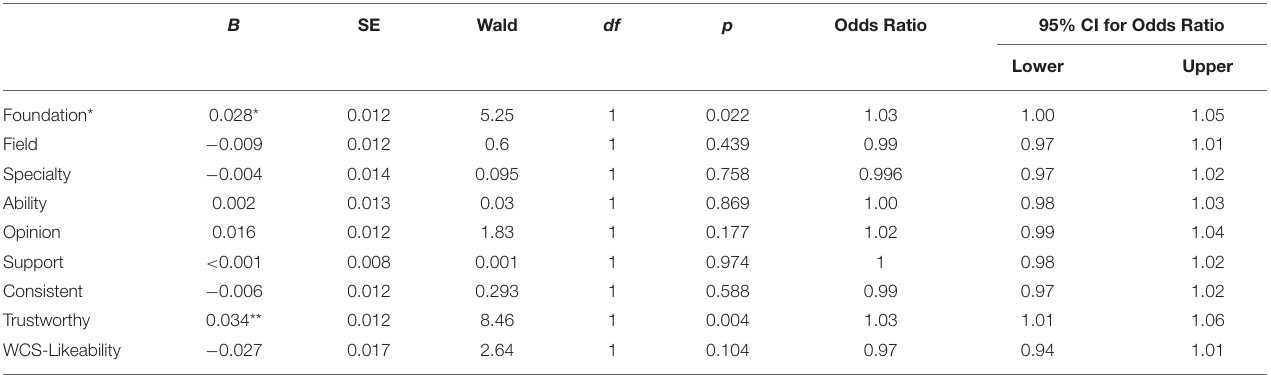
TABLE 6 | Logistic regression predicting sentencing decision from continuous expert persuasion expectancy (ExPEx) ratings and witness credibility score (WCS) for likeability.